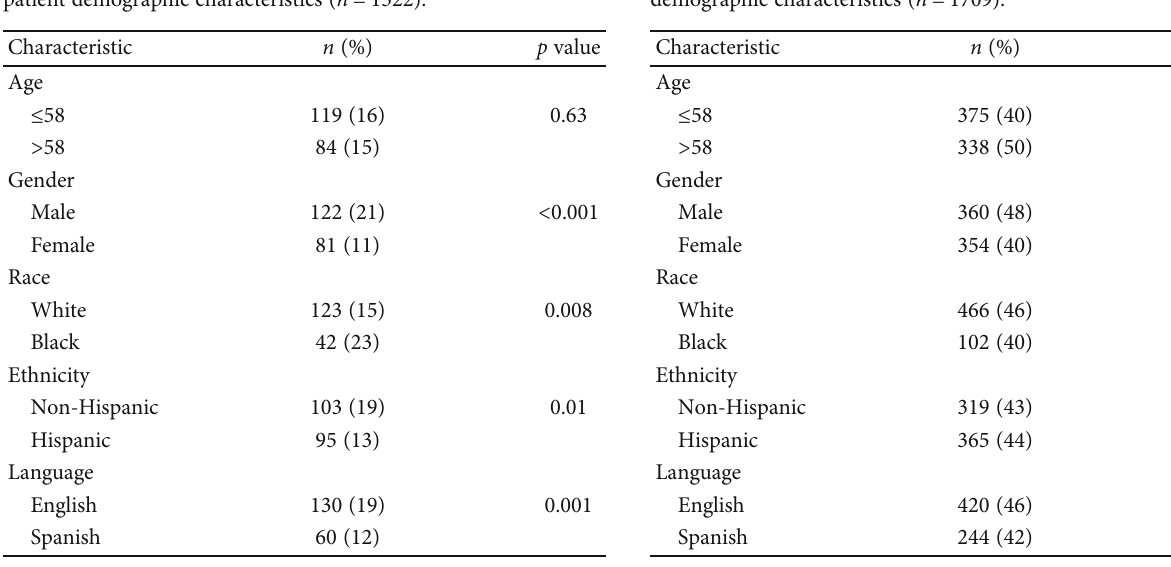
Table 4: Comparison of adenoma detection rate across patient demographic characteristics ( n = 1709